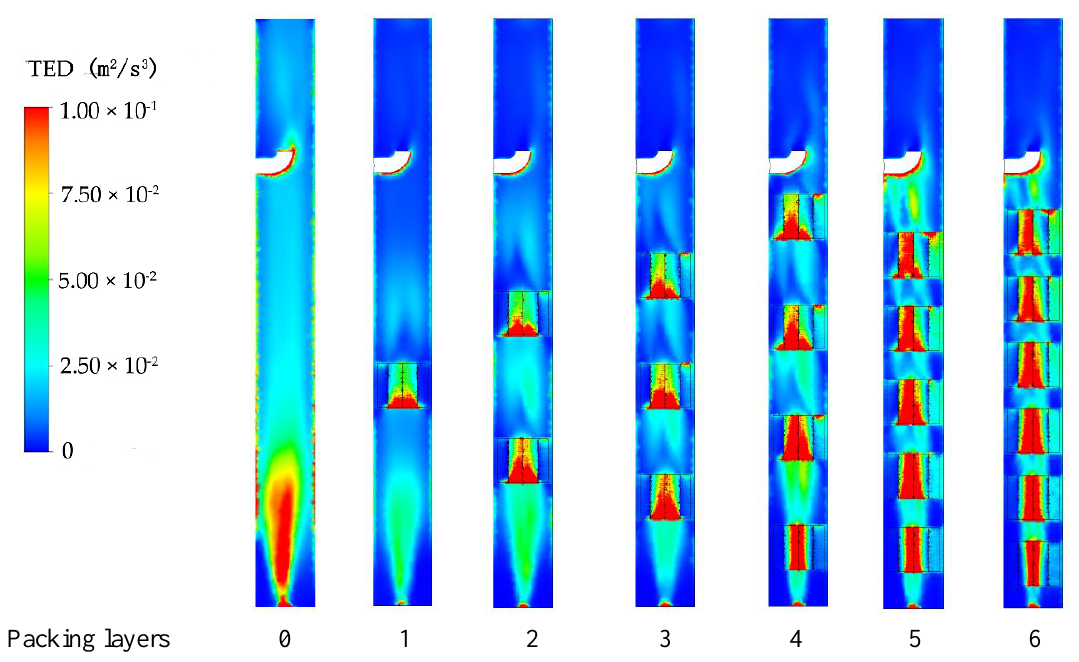
Figure 7. Influence of packing layers on turbulence eddy dissipation characteristics in column.